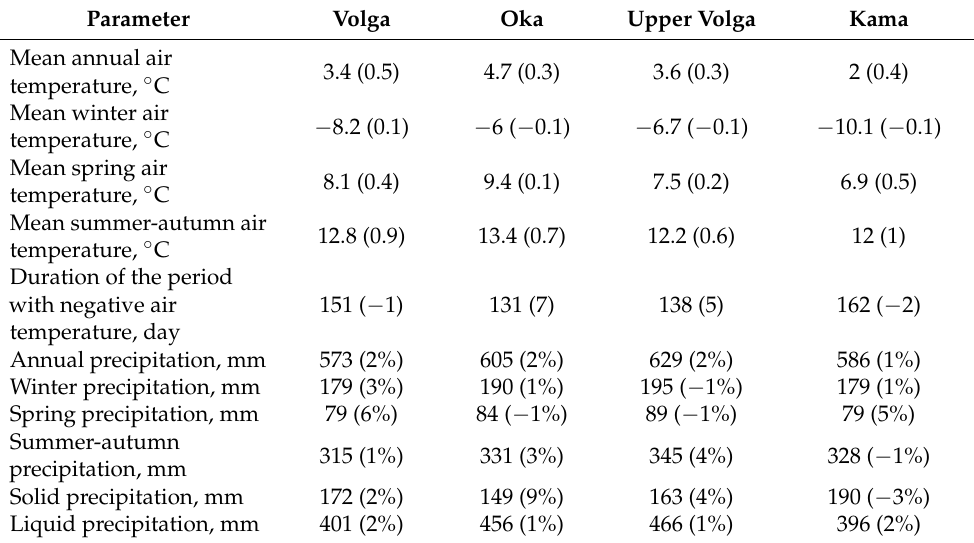
Table 4. Averaged basin mean monthly air temperature and precipitation calculated from observa- tional data for the Volga, Oka, Upper Volga and Kama basins and errors according to the GCMs ensemble data (in parentheses) for the period 1970–1999.